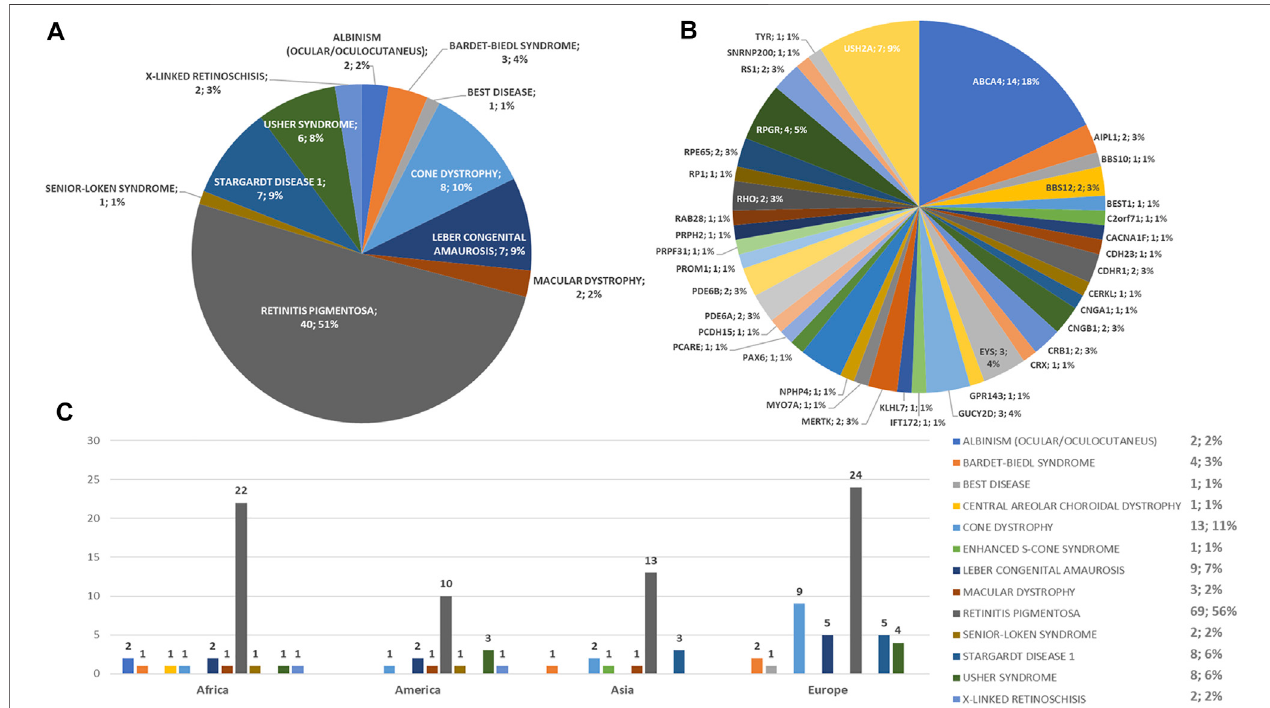
FIGURE1| Phenotypeandgenotypedistributionsofunderstudiedethnicgroups.Piechartsshow (A) thephenotypesand (B) genotypesofpositivecases. (C) Bar chart shows the number of examined patients, divided per phenotype.